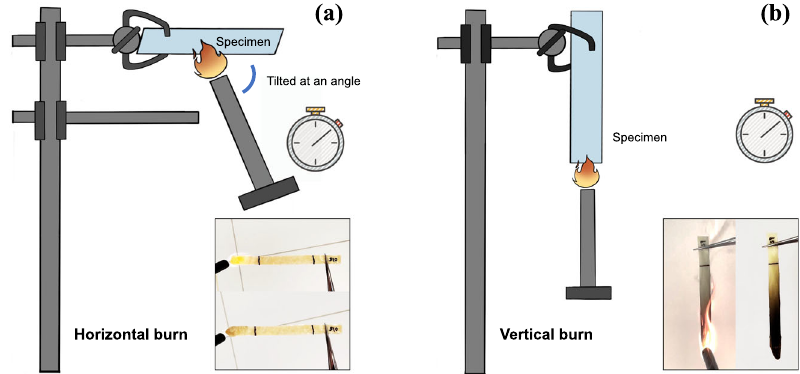
Fig. 4 Flammability test setup a horizontal burn and b vertical burn of polyurea coating according to ASTM D635